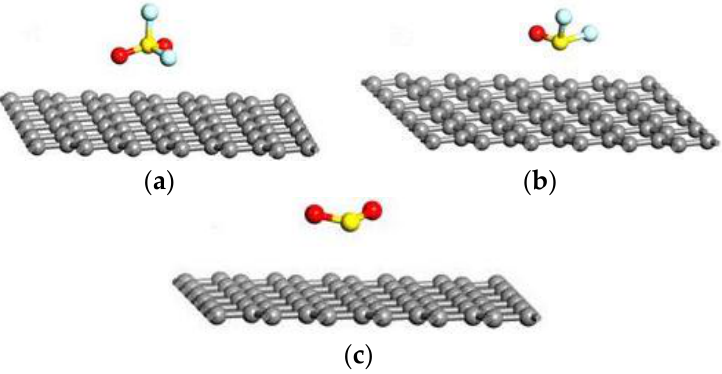
Figure 4. The most stable optimized geometric of single gas molecules interacting with Int-graphene in ( a ) Int-graphene/SO 2 F 2 ; ( b ) Int-graphene/SOF 2 ; and ( c ) Int-graphene/SO 2 . Table 2. Doping formation energy of an Ag-doped graphene